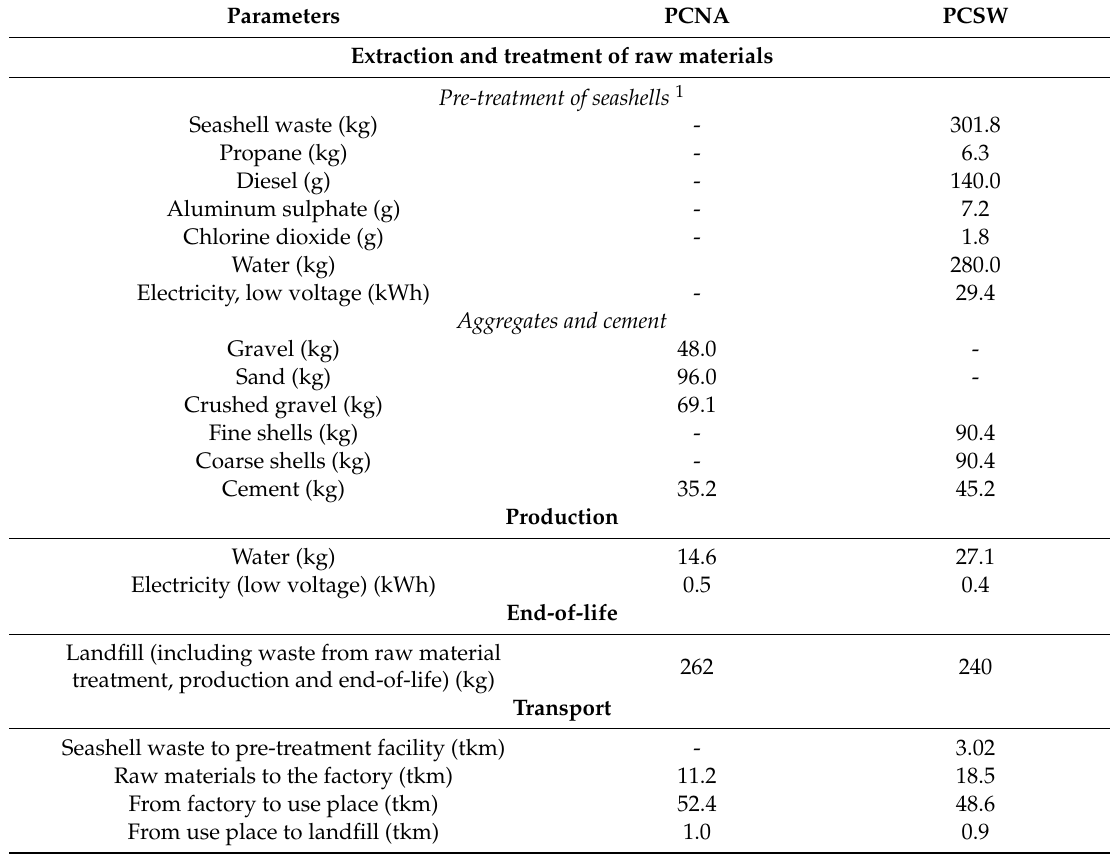
Table 1. Life cycle inventory data for 1 m 2 of noise barrier using porous concrete from natural aggregates (PCNA) and seashell waste